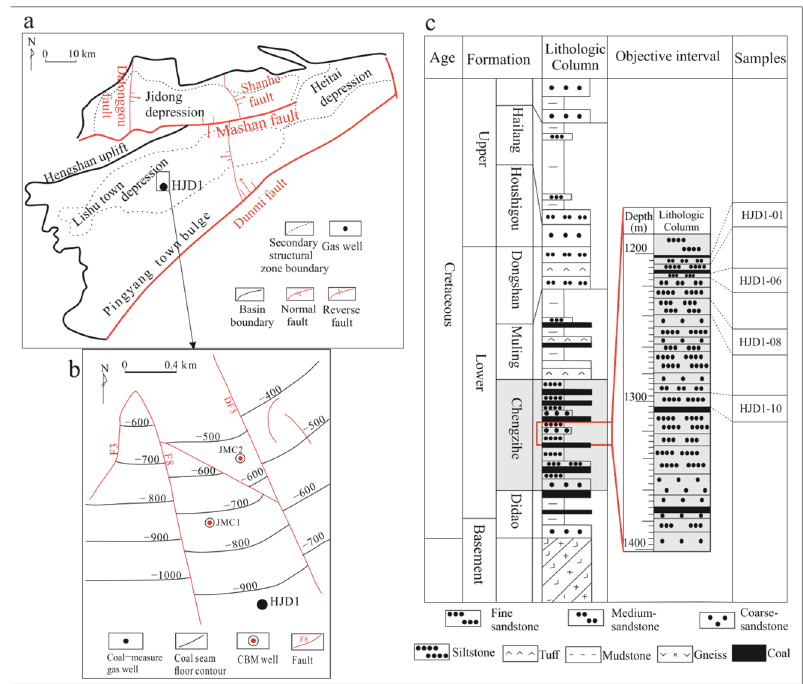
Figure 1. Geological background of the study area: ( a ) Location of Coal-measure Gas Well HJD1 in Jixi Basin; ( b ) geological structure of the area where Well HJD1 is located; ( c ) sampling stratigraphic column in Well HJD1.